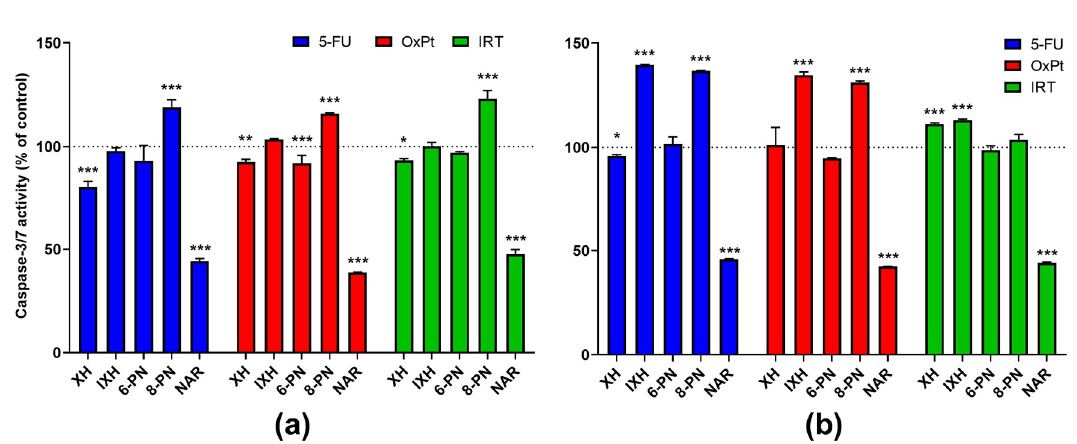
Figure 5 . Effect of flavonoid–cytostatic combinations on the activation of apoptosis in SW620 cells. The activity of caspases 3/7 was assessed after 8-hour incubation (a) and 24-hour incubation (b). Data are presented as a percentage of respective cytostatic-treated control (= 100%) and represent the mean ± S.D. ( n = 3) (* data with p < 0.05, ** p < 0.01, *** p < 0.001, one-way ANOVA with Dunett’s test).